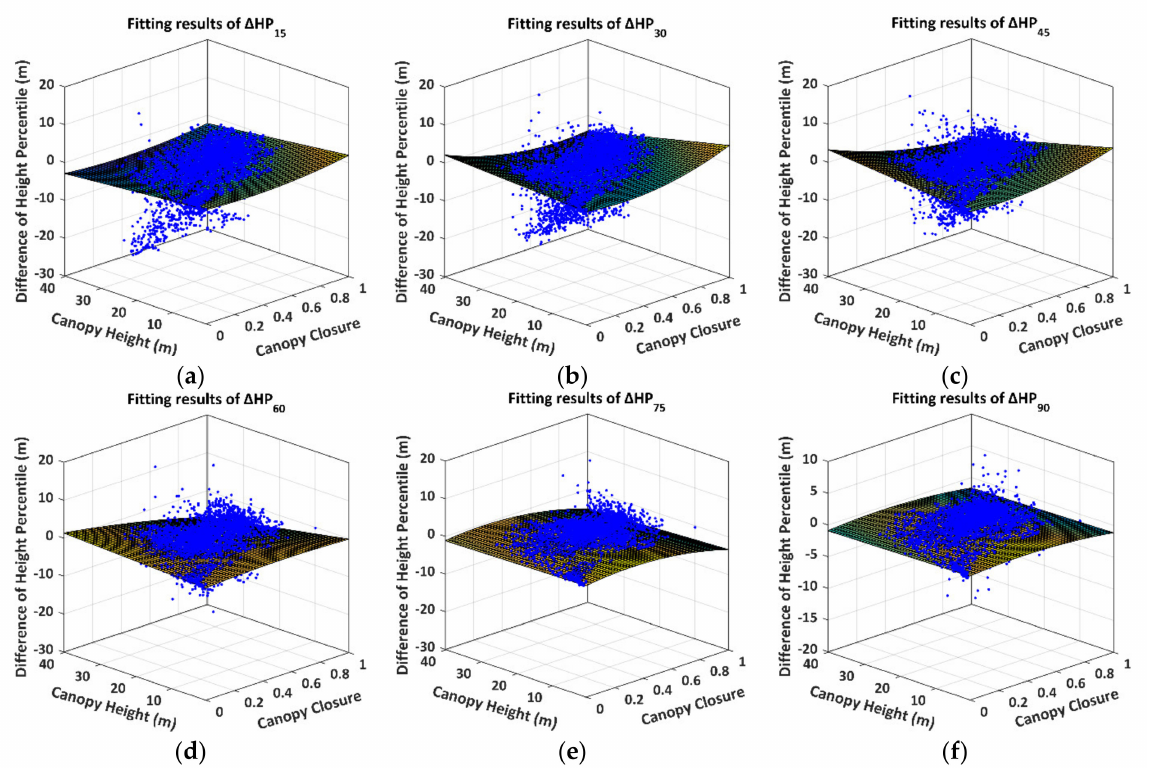
Figure 11. The fitting curved surfaces and original distributions of the DHP. The blue dots and the curved surfaces represent the DHP distributions and the fitting surfaces, respectively. ( a ) ∆ HP 15 ; ( b ) ∆ HP 30 ; ( c ) ∆ HP 45 ; ( d ) ∆ HP 60 ; ( e ) ∆ HP 75 ; ( f ) ∆ HP 90